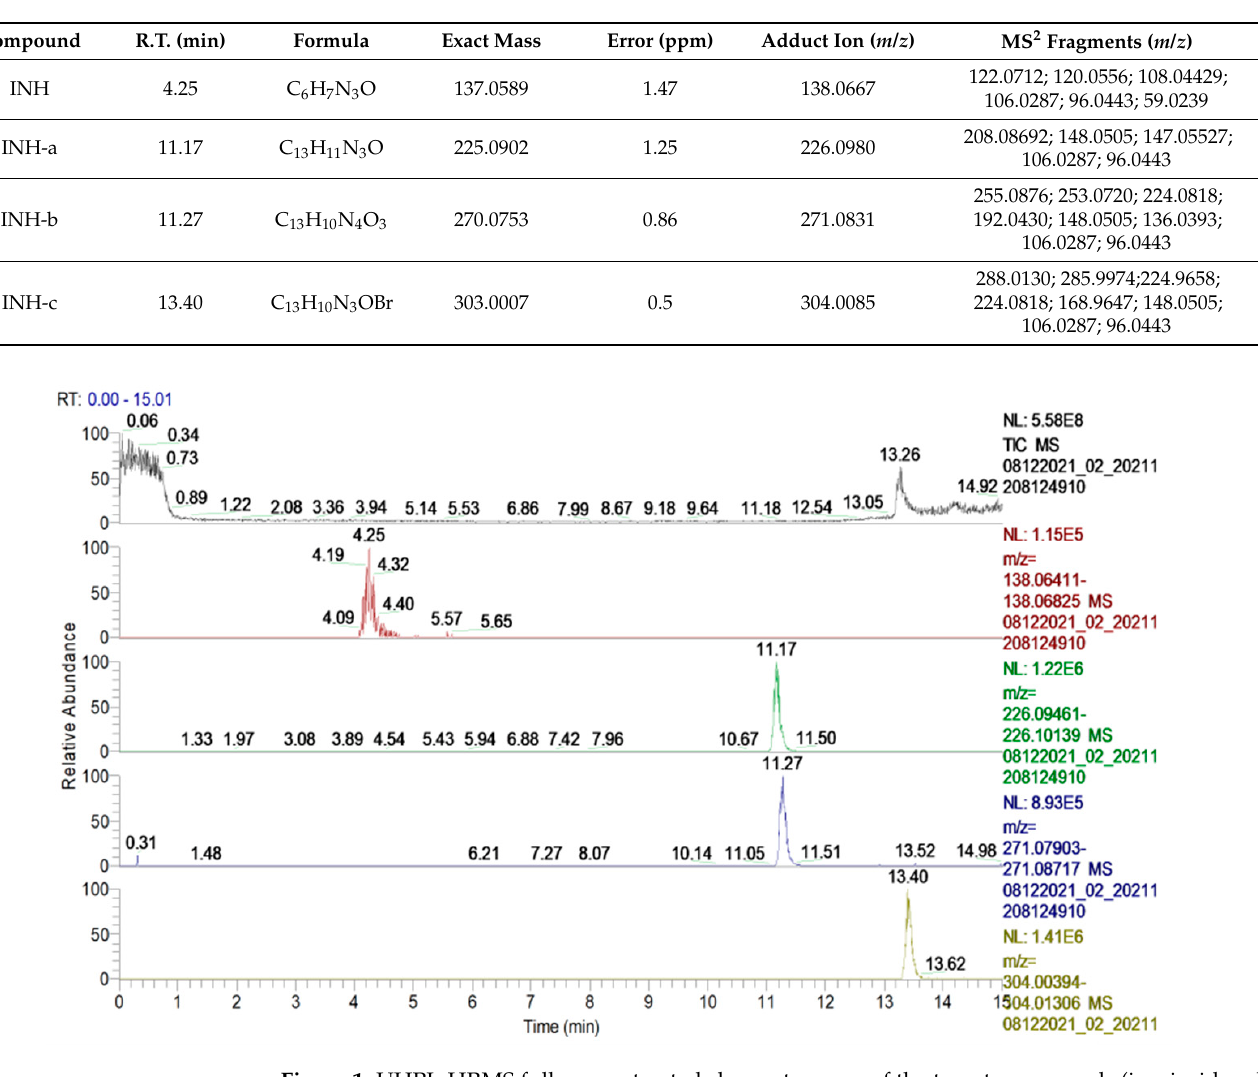
Table 1. The target compounds, deprotonated precursors and fragment ions. The common fragments for the parent compound and its derivatives are in bold.